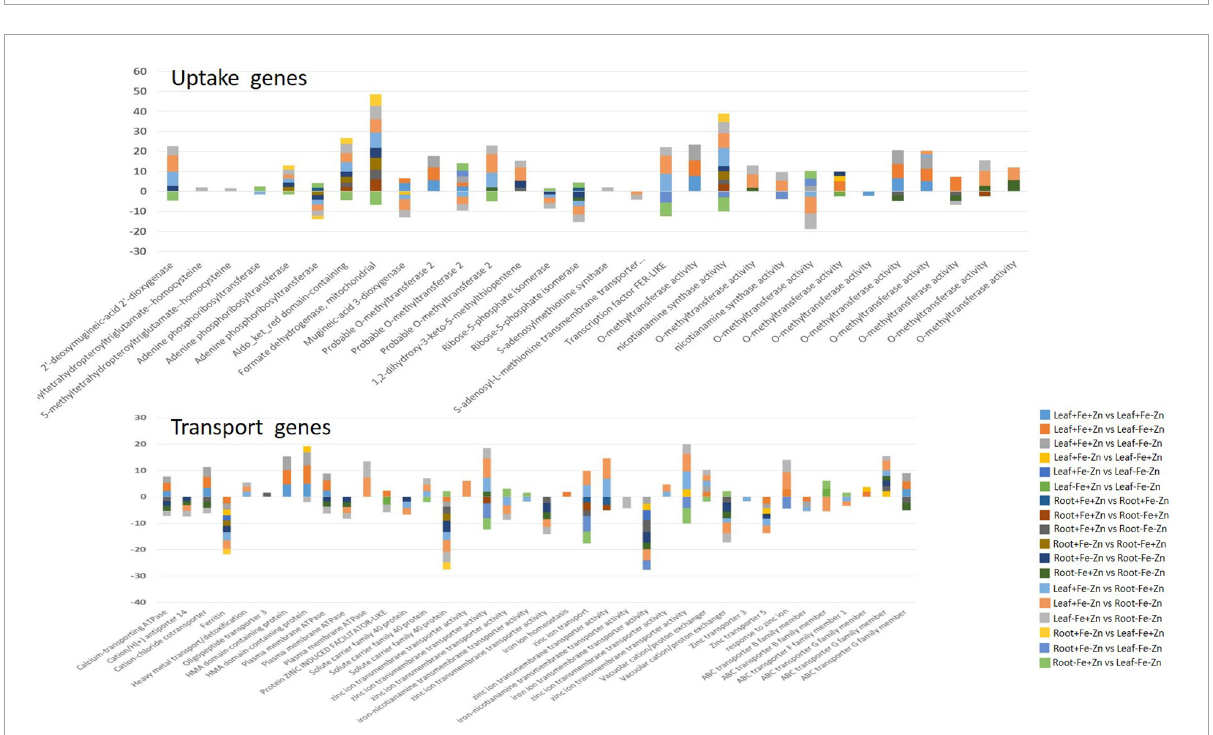
FIGURE8 Important genes associated with the Fe and Zn uptake and transport in the leaf and root tissues of pearl millet under 18 pairwise stress combinations.